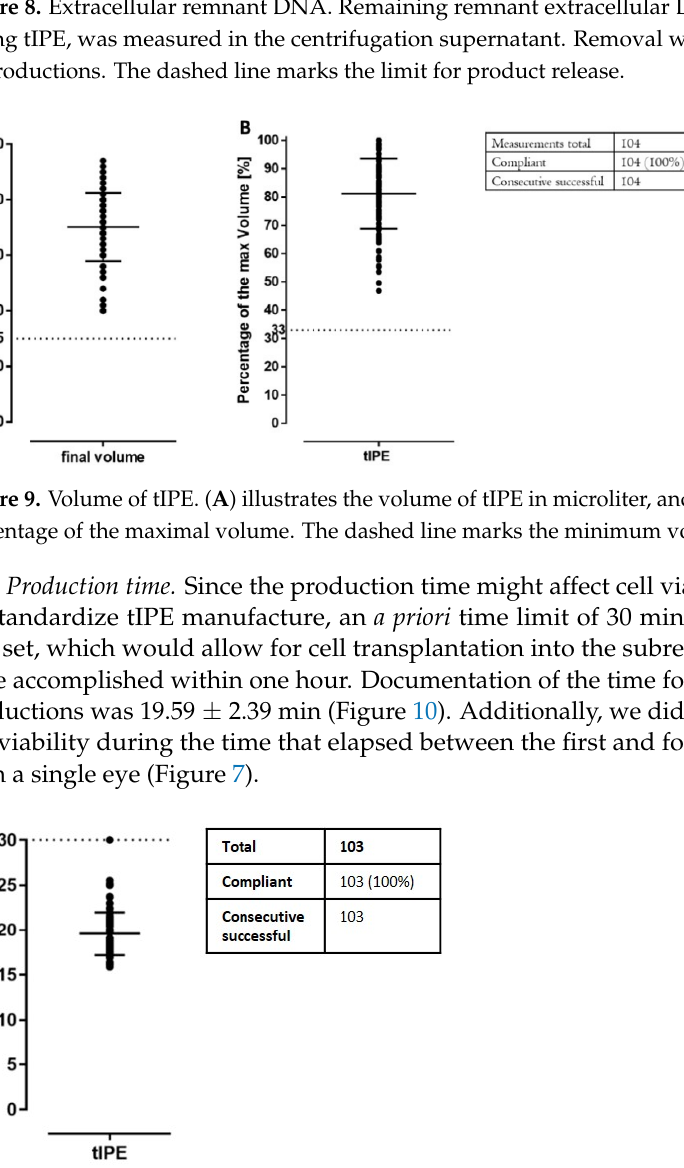
Figure 10. Production time. All recorded 103 productions were below the set 30 min time limit (dashed line).